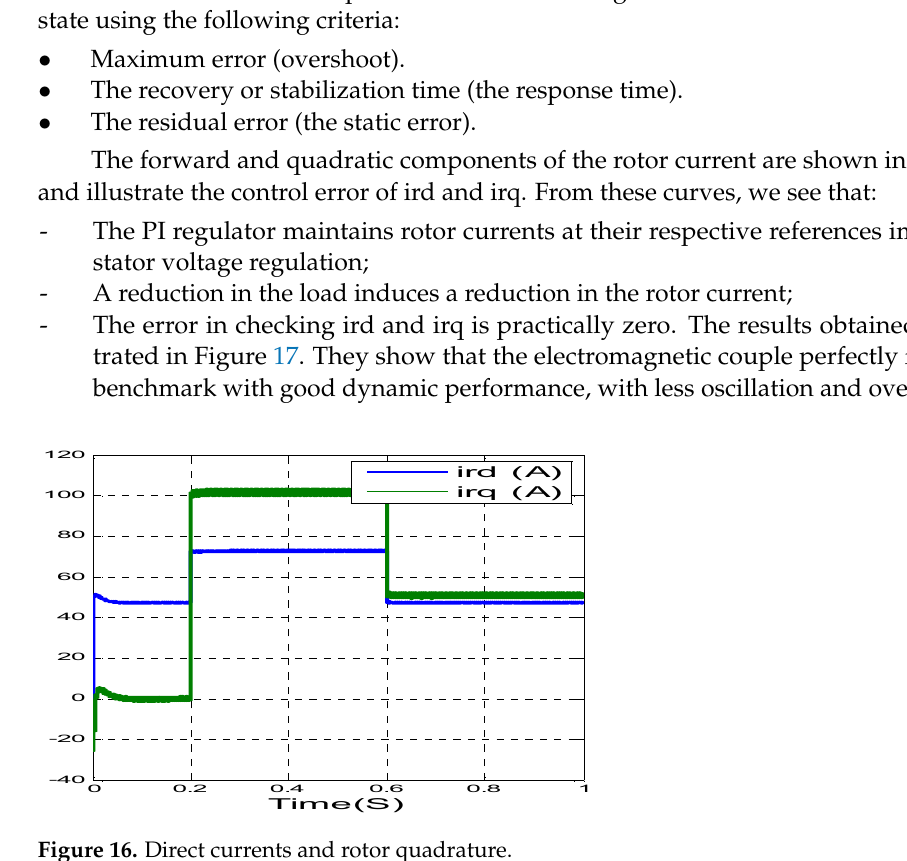
Figure 15. Reactive power stator.